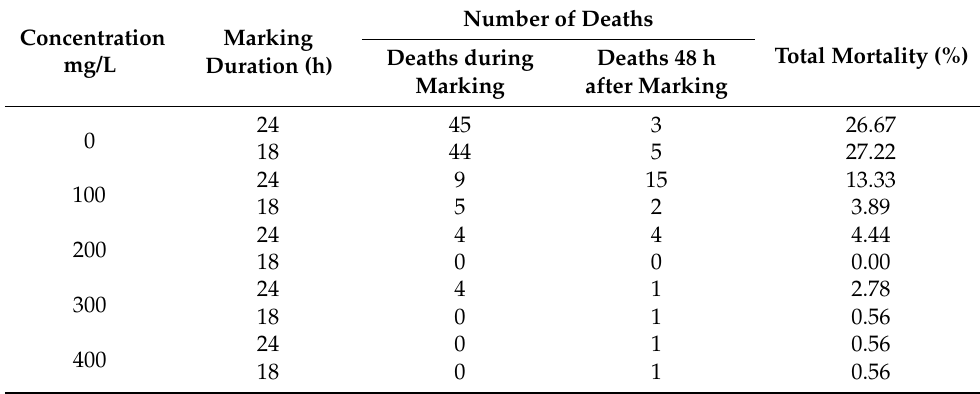
Table 2. Effects of ARS staining on juvenile fish mortality (180 test fish per group).